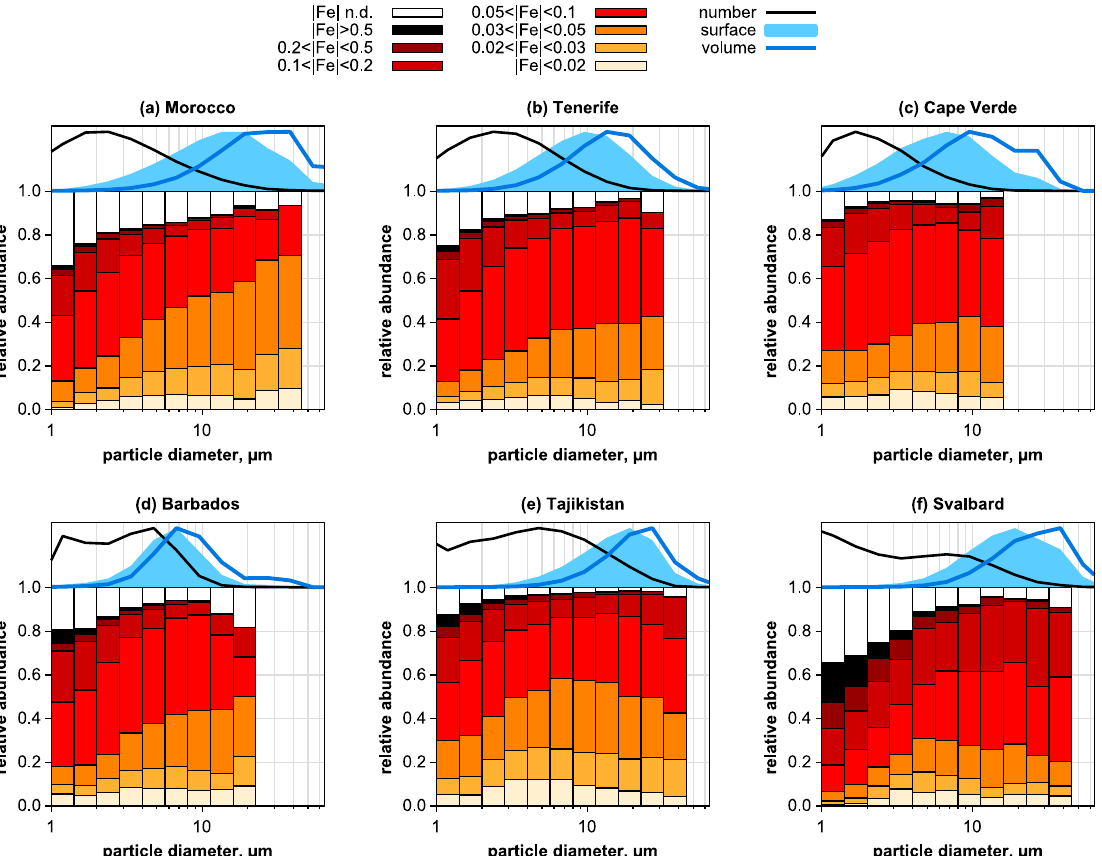
Figure 3. Size-resolved abundance of silicate particles with different iron indices. ( a ) Morocco, ( b ) Tenerife, ( c ) Cape Verde, ( d ) Barbados, ( e ) Tajikistan, and ( f ) Svalbard. On the top, relative size distributions are given for the deposited silicate particles. Black line: number; shaded area: surface / cross-section; blue line: volume. Particle diameter is given as projected area diameter. ‘n.d.’ means not detected. Note that not all samples for ( a ) could be analyzed due to overloading of the sampler during dust storms, so the plot does not include dust storm days. Abundance bars are not shown for size intervals with less than 40 particles to avoid the presentation of data with high statistical uncertainty.